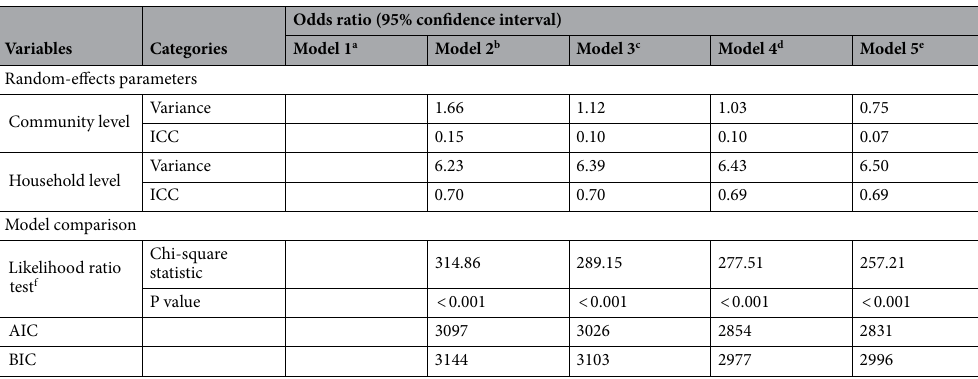
Table 3. Risk factors of suspected developmental delays among Nepalese children (N = 2870). ref. reference category, ppm parts per million, SD standard deviation, SE standard error. ***p < 0.001, **p < 0.01, *p < 0.05. a Model 1: crude models. b Model 2: only child characteristics were included in the model. c Model 3: additionally adjusted for parental characteristics. d Model 4: additionally adjusted for household related characteristics. e Model 5: additionally adjusted for community characteristics. f Based on the results on likelihood ratio tests, estimates of multilevel logistic regression models were preferred than fixed effect